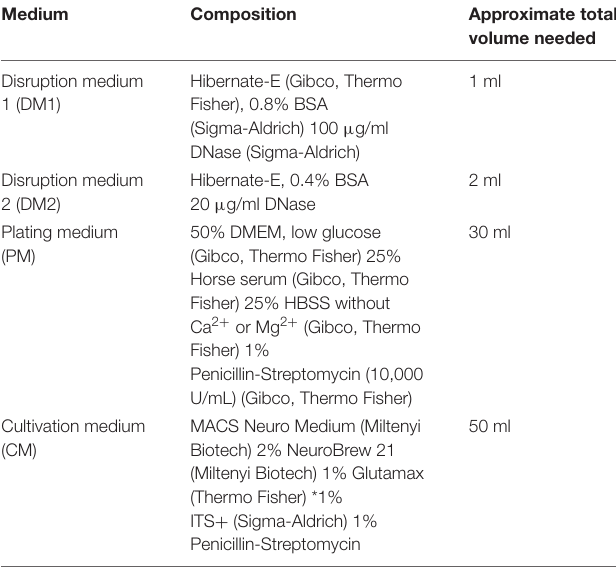
TABLE 1 | Media compositions used for preparation and maintaining spinal cord